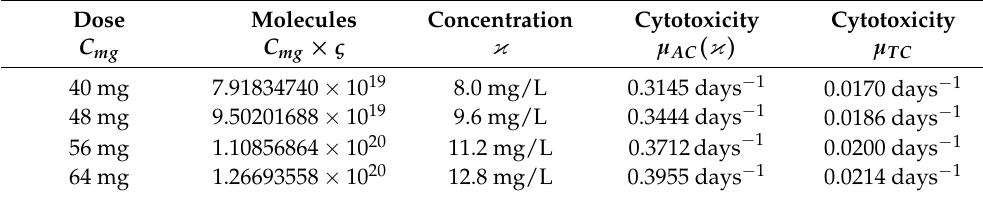
Table 6. Chlorambucil characteristics for the chemoimmunotherapy protocol cases. Dose Molecules Concentration Cytotoxicity